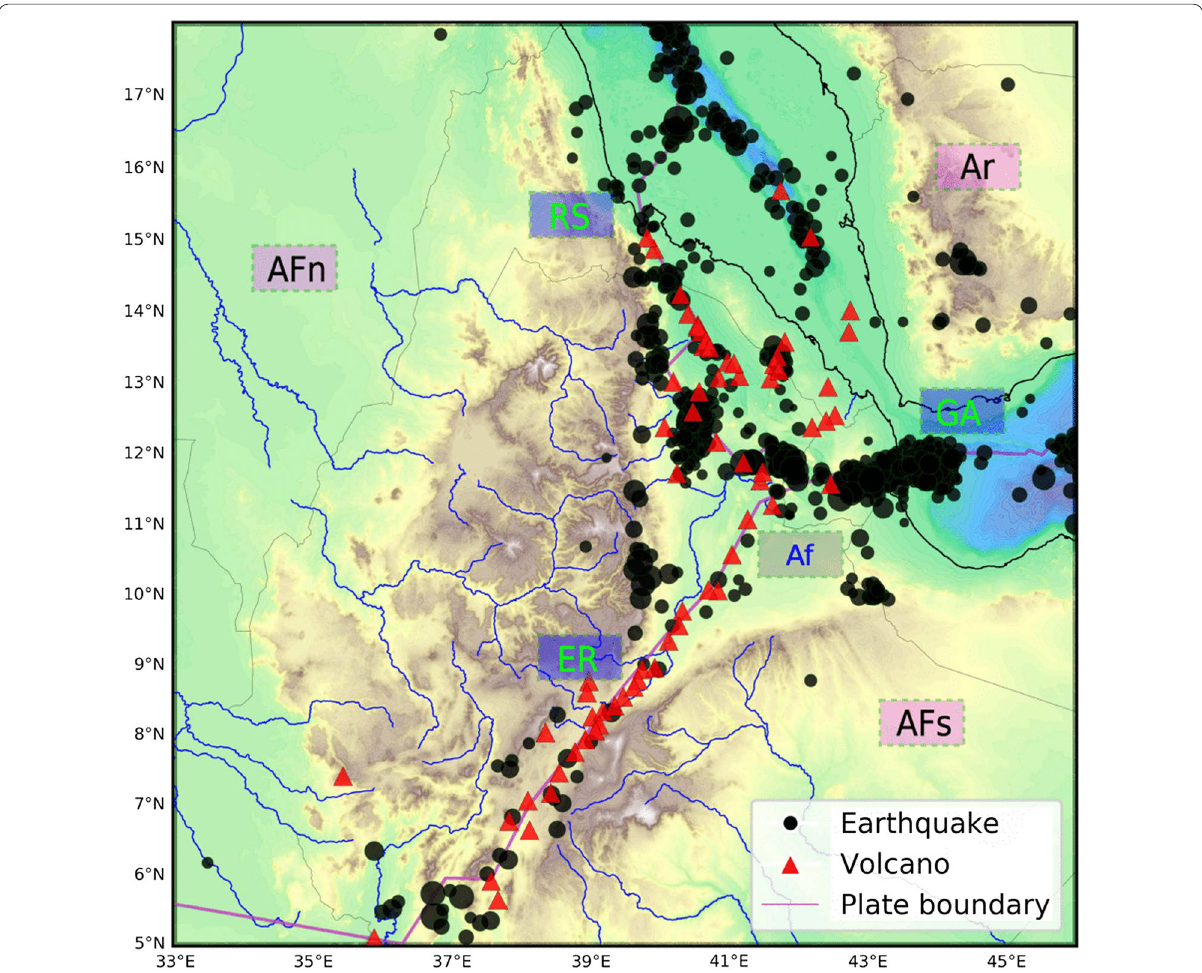
Fig. 1 Tectonic setting of the Afar triple junction. The red triangles are active Holocene volcanoes (Venzke 2013). The magenta line represents the plate boundary (Bird 2003). The black circles represent the locations of the epicenters of Earthquakes ( M w > 4 ). Most of the Earthquakes in the region have shallow depths. The black text framed in magenta provides the names of the different plates (Bird 2003): AFn, African (Nubian) plate; AFs, African (Somalian) plate; Ar, Arabian plate. The green text framed in blue provides the names of the three rifts: ER, Eden rift; GA, Gulf of Aden; R,- Red Sea rift. The blue text framed in brown (Af) indicates the location of the Afar triple